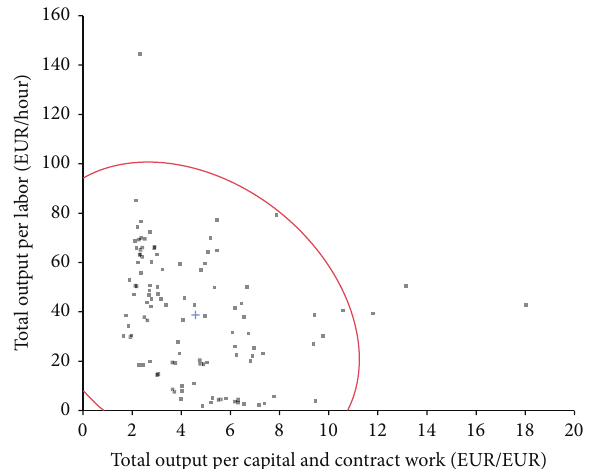
Figure 1: Relationship between labour productivity and capi- tal/contract work productivity.